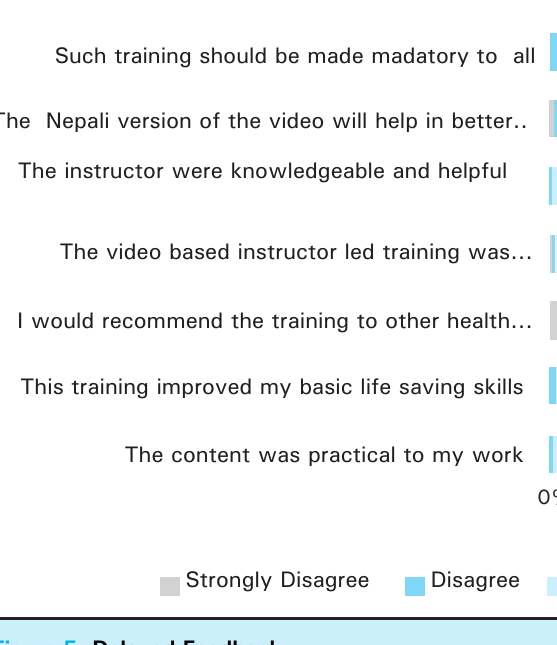
Figure 5. Delayed